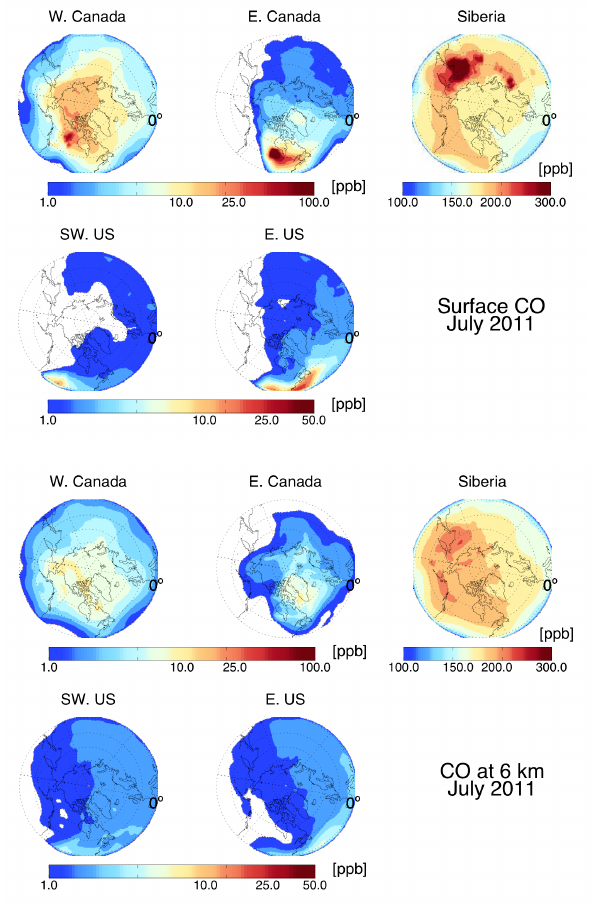
Fig. 9. Monthly mean GEOS-Chem global 3-D chemistry model output for July 2011 that describes pyrogenic contributions to total CO (ppb) from Western Canada, Eastern Canada, Siberia, south- western contiguous US and eastern contiguous US. The upper (lower) panel shows CO concentration at the surface